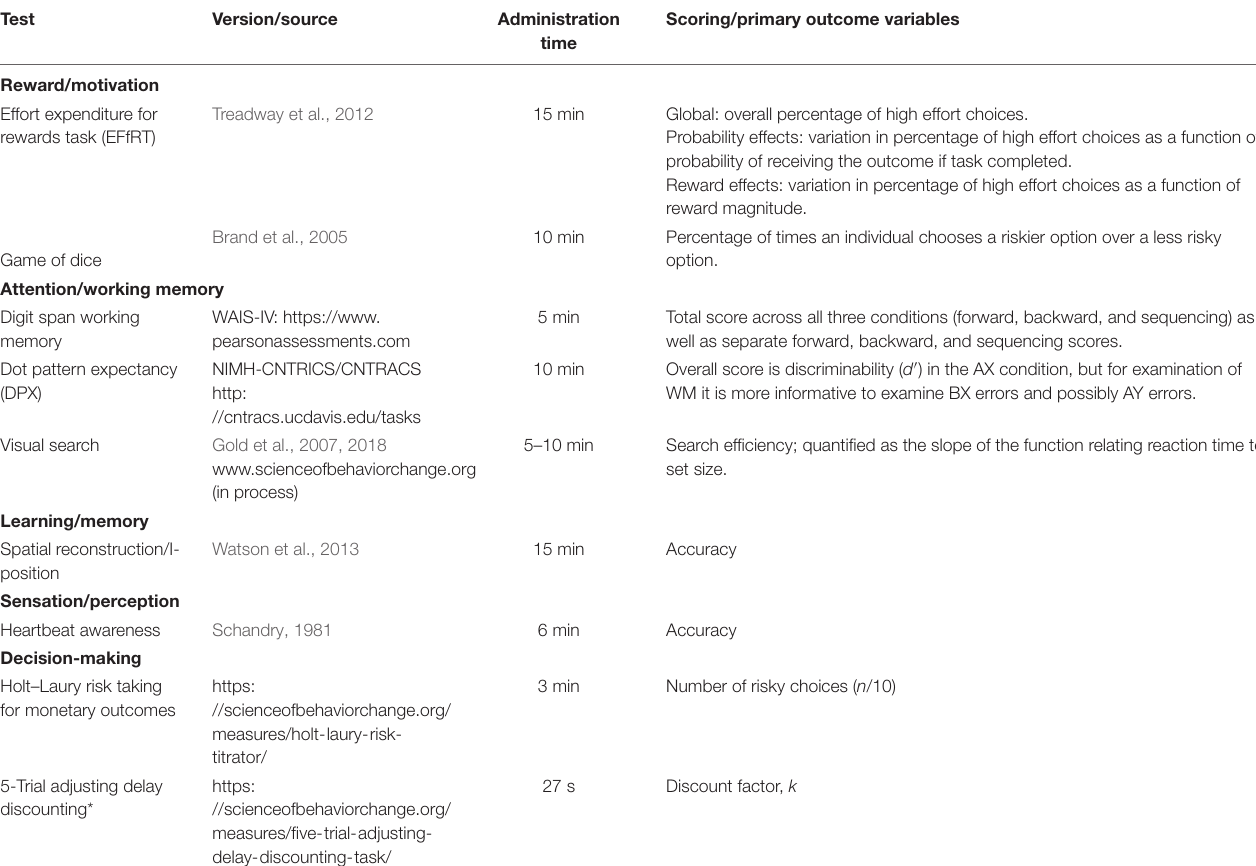
TABLE 4 | Extended